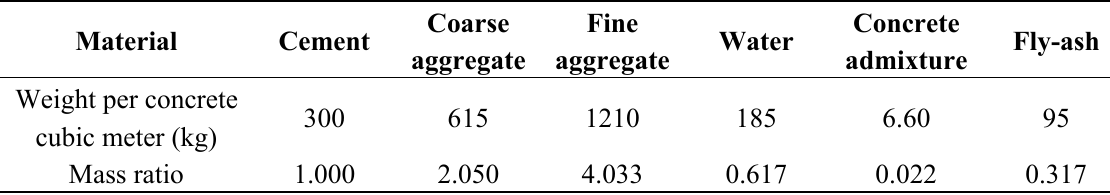
Table 1. The mix proportion for